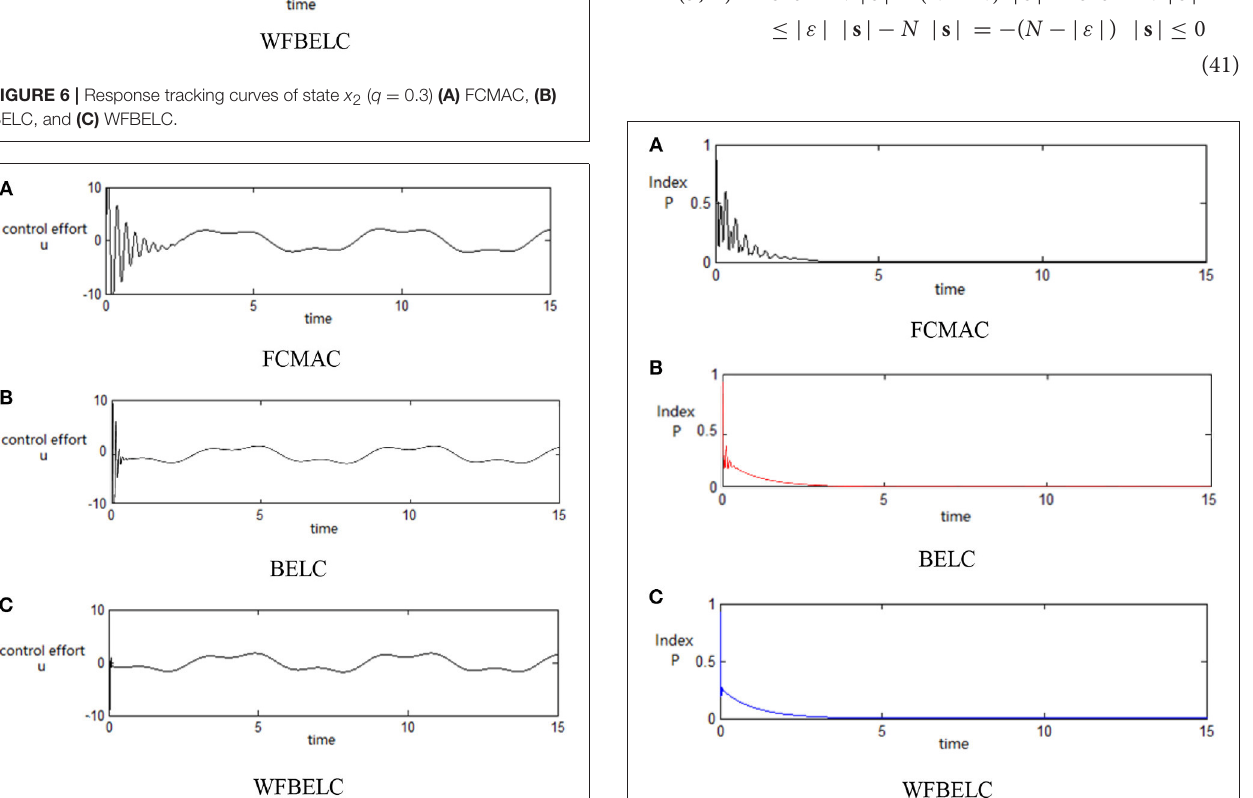
FIGURE 8 | Performance Index P ( q = 0.3) (A) FCMAC, (B) BELC, and (C)